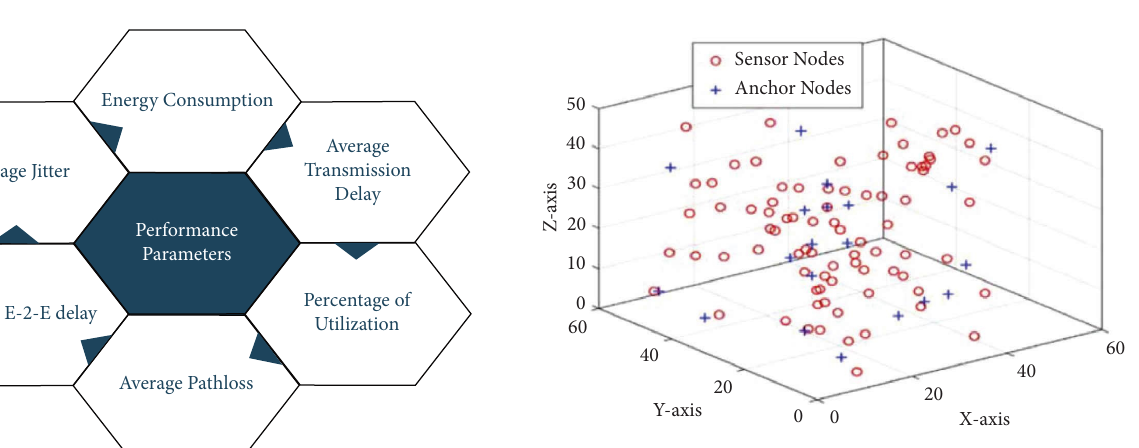
Figure 9: Deployment of sensor nodes in 3D for the proposed underwater wireless sensor